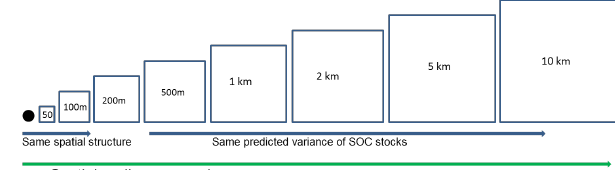
Figure 2: Figure 2. The spatial scaling approach used in this study. The black dot represents the location of an SOC sampling site, and the rectan- gles denote different pixel sizes of environmental variables (rectan- gles are not to